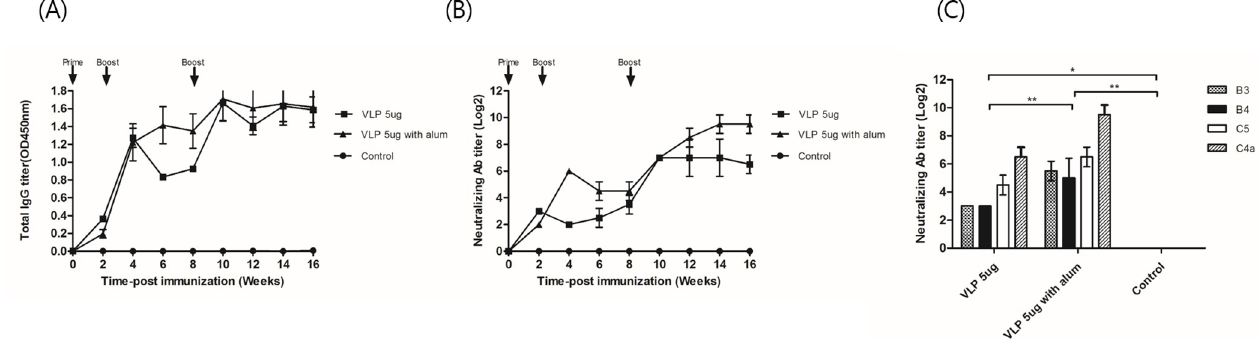
Fig 4. Humoral immune response induced by EV71 C4a VLP-gp41 in mice. The titer of EV71 antibody in each of 5 groups of mice that received EV71 VLP (5 μ g), VLP (5 μ g) with alum, or phosphate-buffered saline (PBS) as a control according to immunization schedule as indicated by the arrows. (A) Titers of total IgG antibodies agains EV71 VLP were determined by ELISAs. (B) The titer of the neutralizing antibody against EV71 C4a was assayed by the titer of the serum in a microneutralization assay. The virus titer of EV71 C4a was 100 TCID 50 . (circle, wild type; square, VLP 5 μ g; triangle, VLP 5 μ g with alum). (C) Mice received EV71 VLP (5 μ g), VLP (5 μ g) with alum, or control and each titer was tested for cross-reactivity in mice against other EV71 subtypes by assaying the titer of the serum in a microneutralization assay. The virus titers of EV71 B3, B4, and C5 were each 100 TCID 50 , respectively (dot bar, EV71 B3 type; black bar, EV71 B4 type; white bar, EV71 C5 type; diagonal line bar, EV71 C4a). These data represent the means of two replicates and error bars indicate SD of the mean. Data statically analysis was performed by one way ANOVA, p <